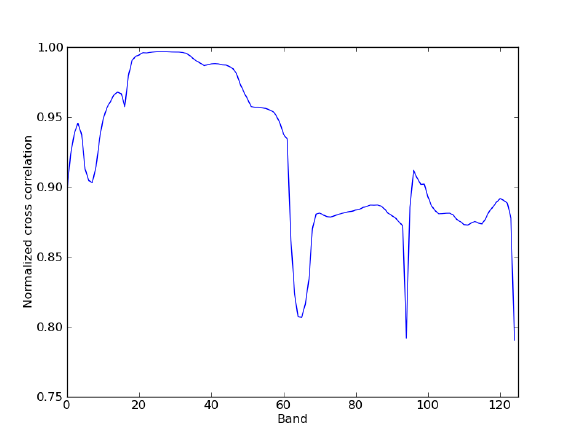
Figure 2: Plot of the normalized cross correlation computed for each band. Value 1 for normalized cross correlation means that signals are ideally correlated 0 when there is no correlation be- tween the